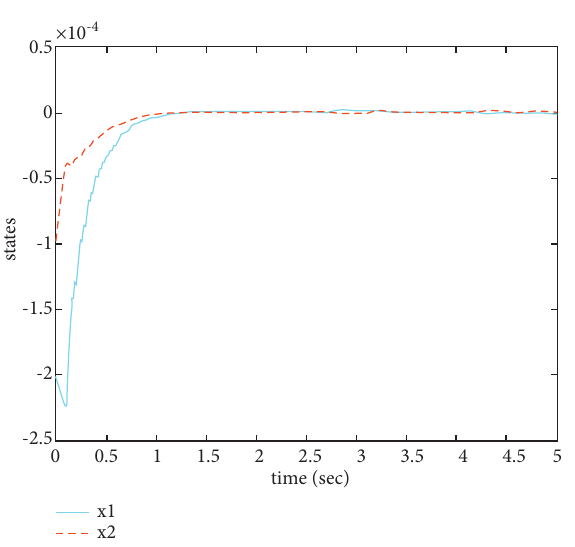
Figure 3: The state response of Example (35) with a bounded input u ( t ) � cos ( 96 t )